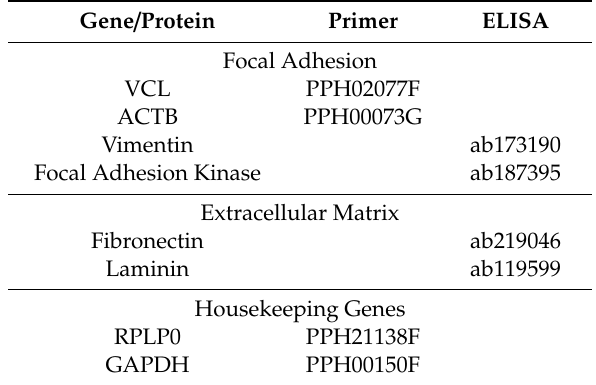
Table1. PrimersusedforRT-qPCR(Qiagen, Hilden, Germany)andELISAkits(Abcam,